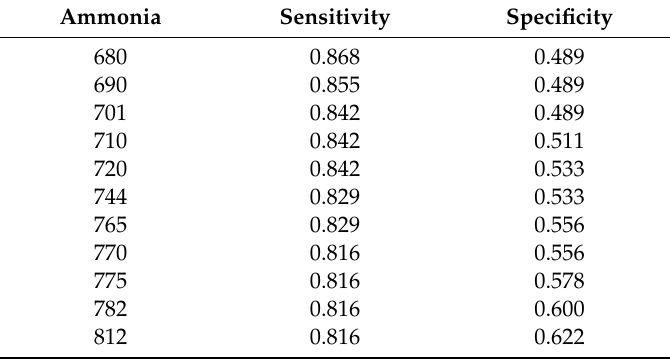
Table 2. Sensitivity and specificity of breath ammonia in predicting patients with < 60 mL / min / 1.73 m 2